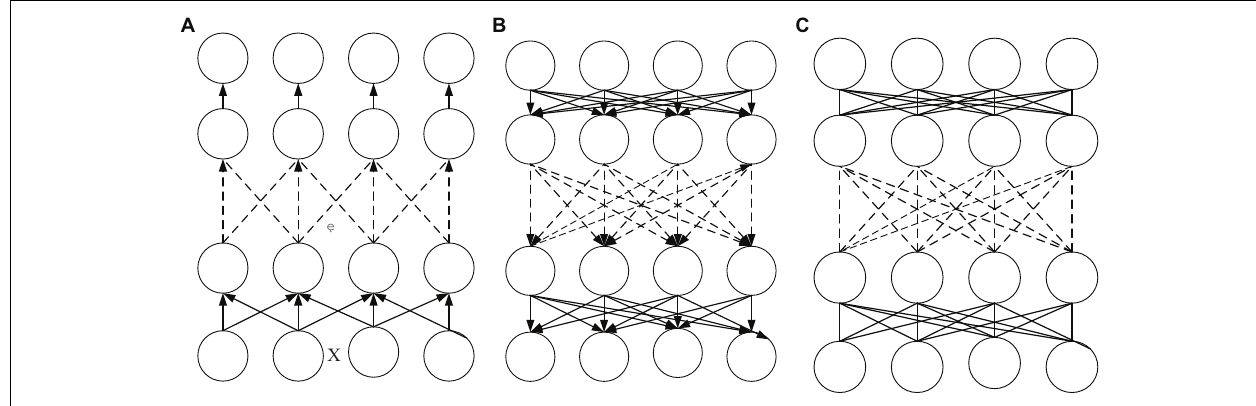
FIGURE 2 | Deep neural networks. (A) CNN (B) Deconvolution Neural Network (C) DL model based on Restricted Boltzmann Machine